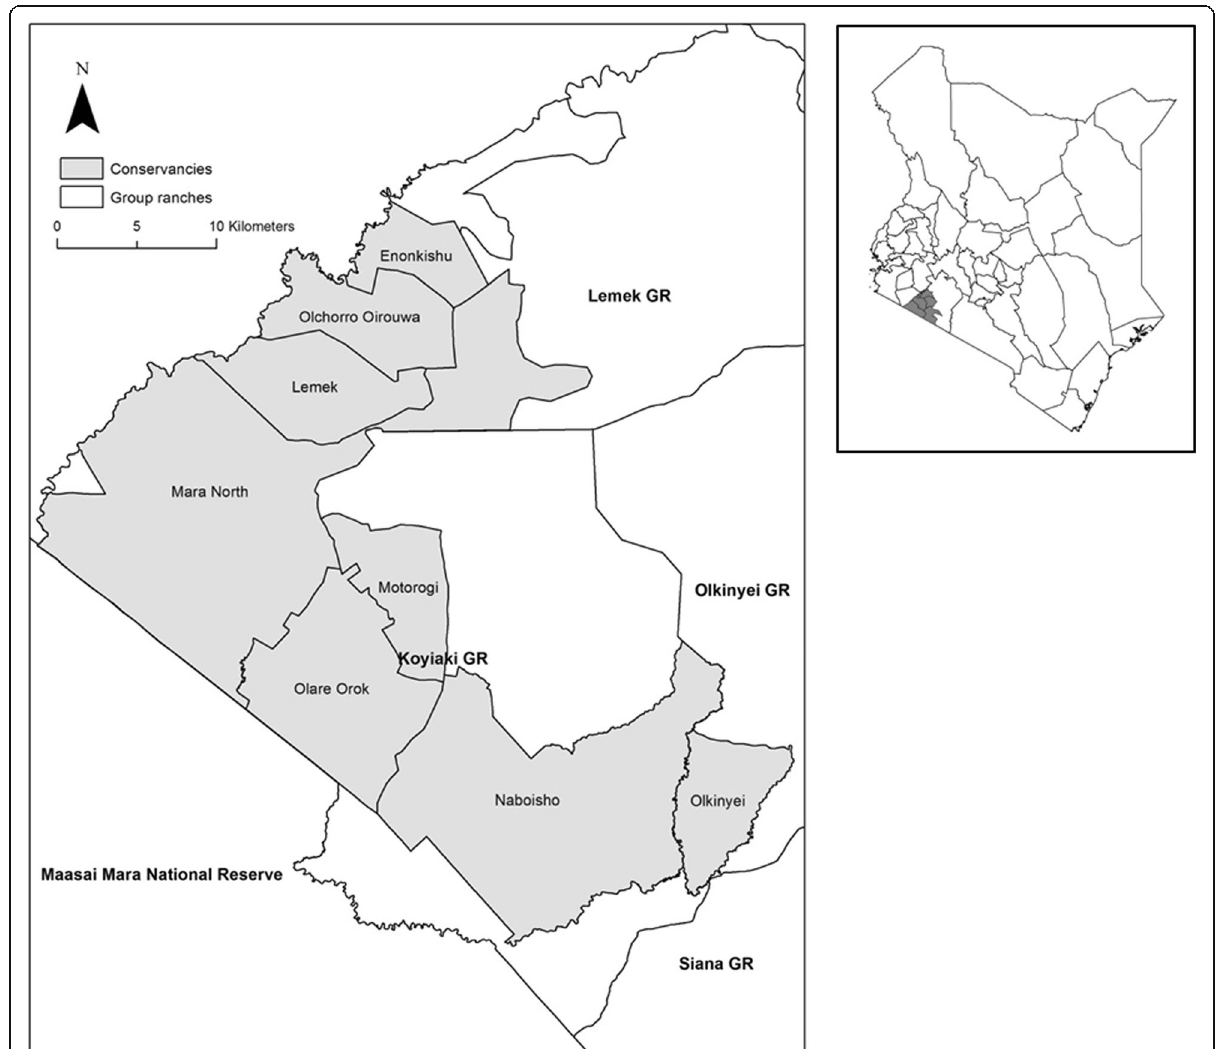
Figure 1 The Mara area, showing the MMNR, the surrounding group ranches and conservancies. Our study area focused on Koyiaki Group Ranch which is made up of the Mara North, Olare Motorogi and Naboisho Conservancies, and surrounding community areas shown in